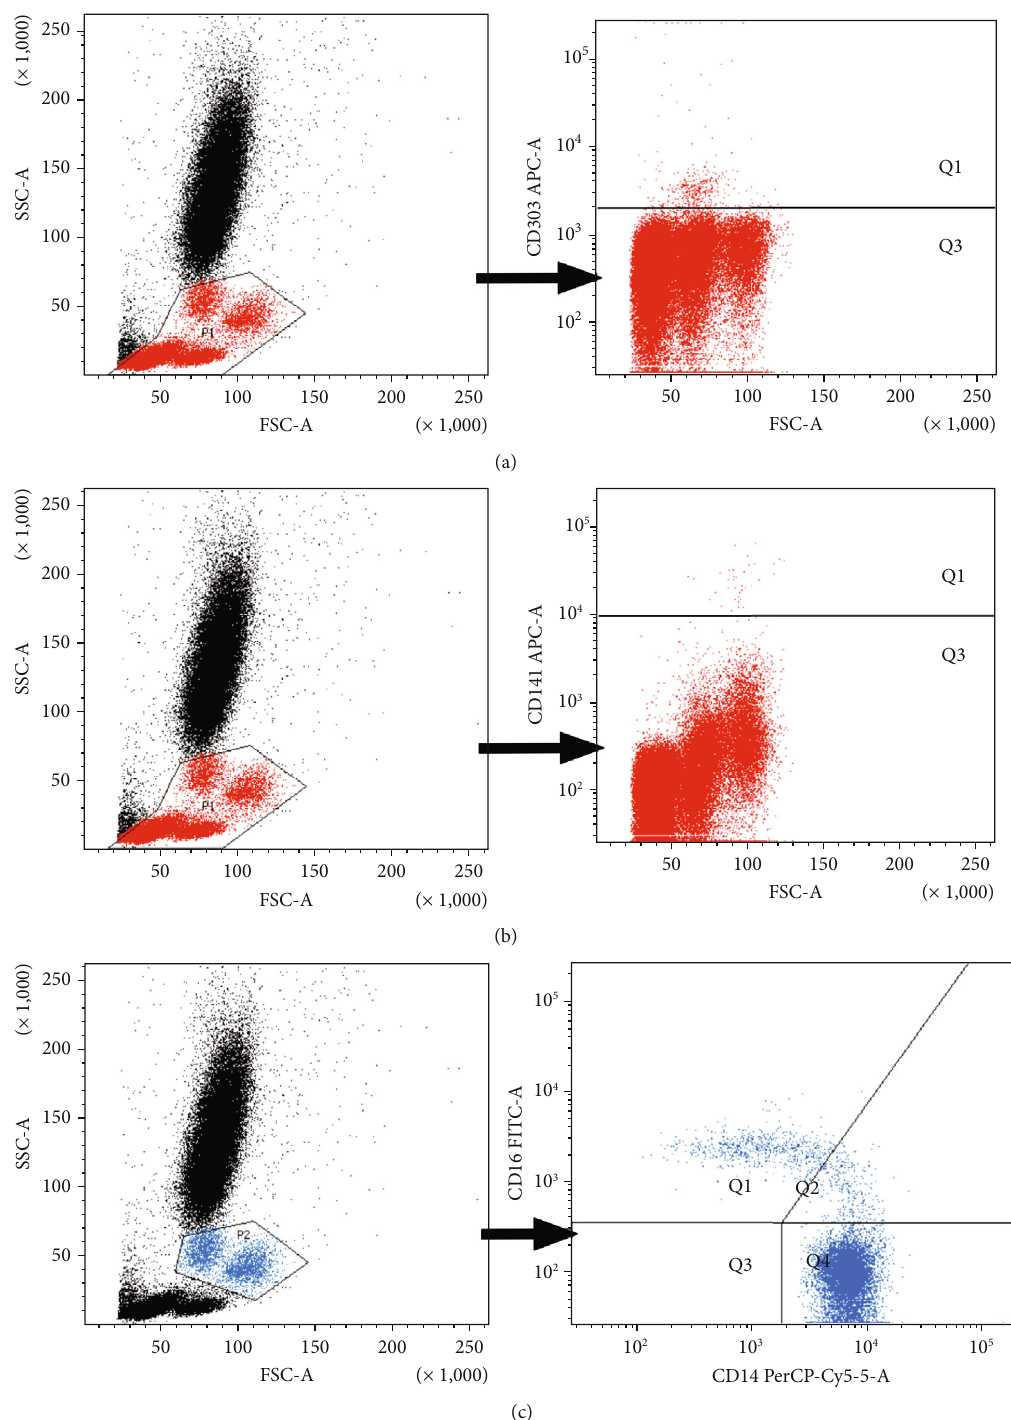
Figure 1: Exemplary plots of fl ow cytometry analysis showing the gating strategy of analyzed leukocyte populations. (a) Distribution of cellular populations in forward and side scatter (FSC-SSC) picture, PBMCs gated for further DC analysis (gate P1), and exemplary plots of fl ow cytometry analysis showing the staining with antibodies speci fi c for pDCs in mononuclear leukocyte fraction: BDCA2/CD303 pDCs (quadrant Q1). (b) Distribution of cellular populations in forward and side scatter (FSC-SSC) picture, PBMCs gated for further DC analysis (gate P1), and exemplary plots of fl ow cytometry analysis showing the staining with antibodies speci fi c for mDCs in mononuclear leukocyte fraction: BDCA3/CD141 mDCs (quadrant Q1). (c) Distribution of cellular populations in forward and side scatter (FSC-SSC) picture, monocytes gated for further analysis (gate P2, blue population), and exemplary plots of fl ow cytometry analysis showing the staining with antibodies speci fi c for CD14 and CD16 in monocyte fraction. Gating of individual monocyte subpopulations is presented: monocytes (CD14highCD16 − ) (quadrant Q4), monocytes (CD14highCD16+) (quadrant Q2), and monocytes (CD14lowCD16+) (quadrant